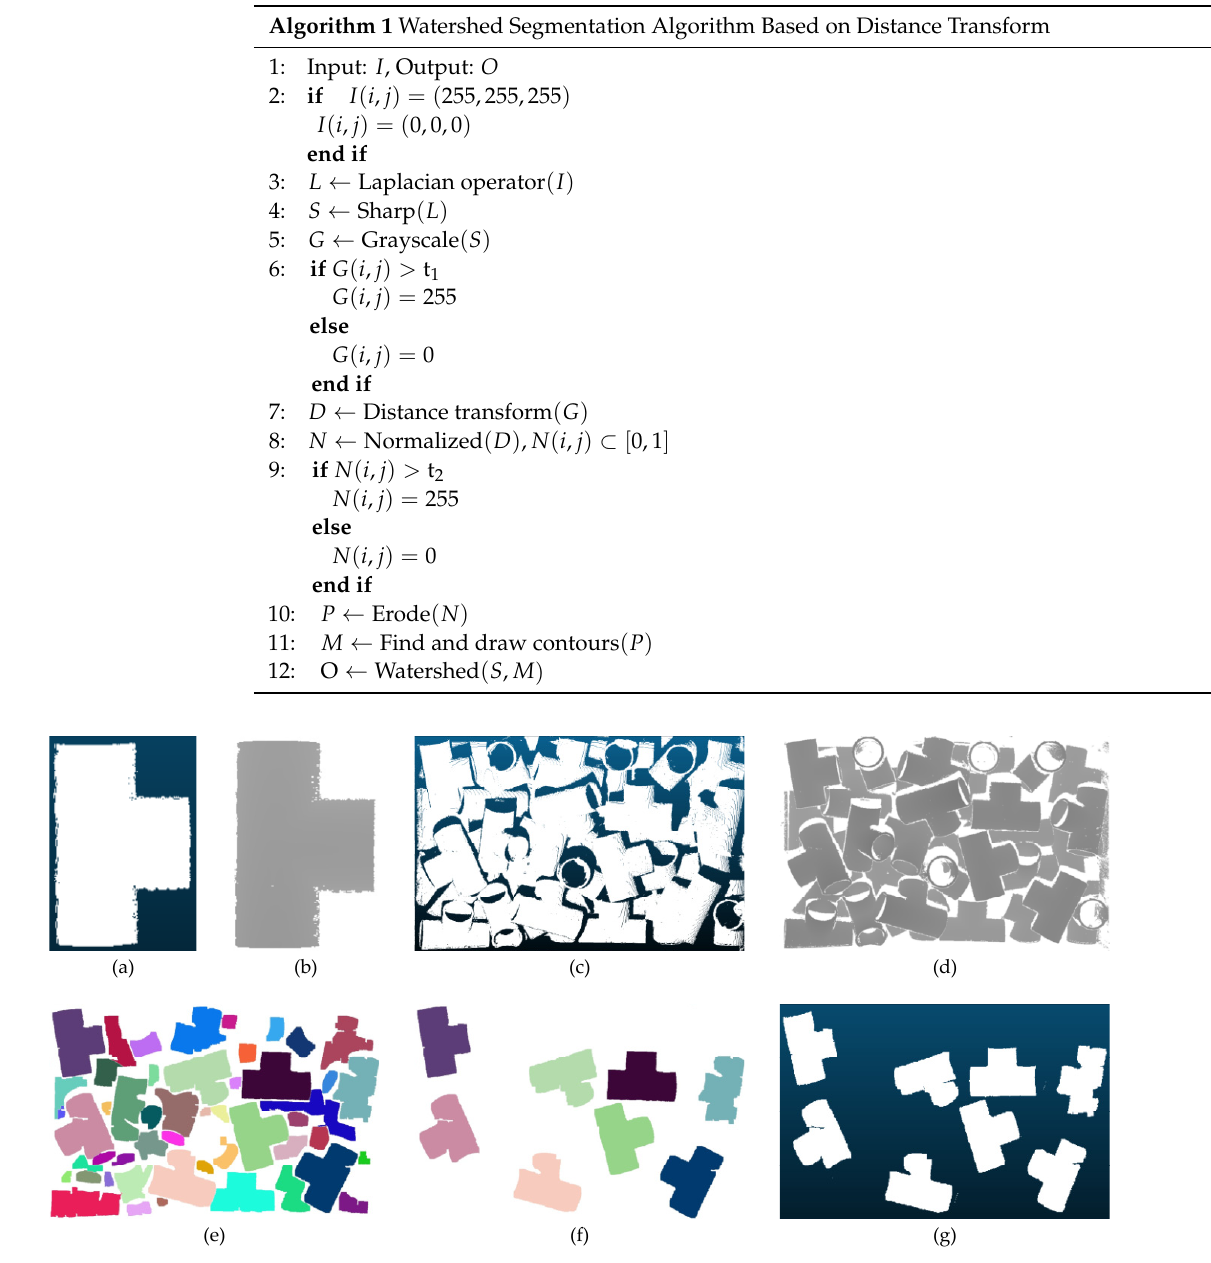
Figure 5. The process of point cloud segmentation and candidate targets selection. ( a ) is the point cloud of the one-sided model; ( b ) is the grayscale image of the one-sided model; ( c ) is the point cloud of the scene; ( d ) is the grayscale image which is mapped from the depth information of the scene; ( e ) is the grayscale image of the scene after segmentation; ( f ) is the grayscale image of the scene after target selecting; and ( g ) is the point cloud which is mapped by ( f ).